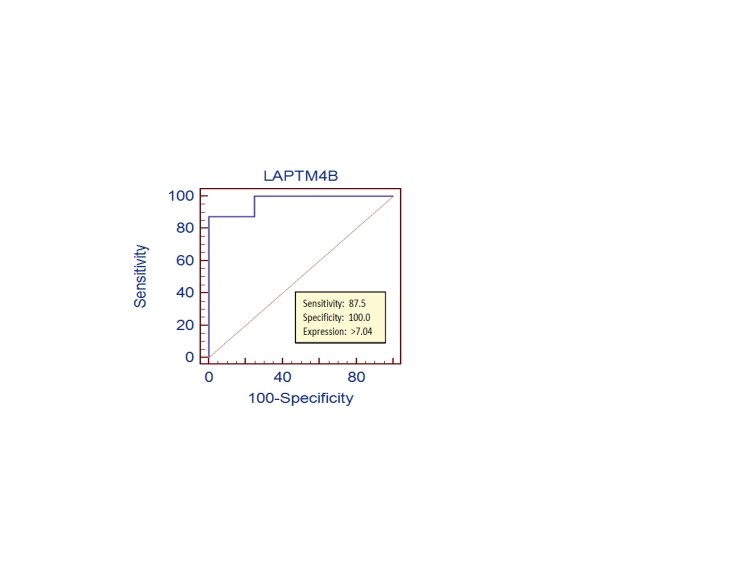
The ROC curve of LAPTM4B as a discriminator between cancer and control samples in the WD group (with AUC of 0.97).